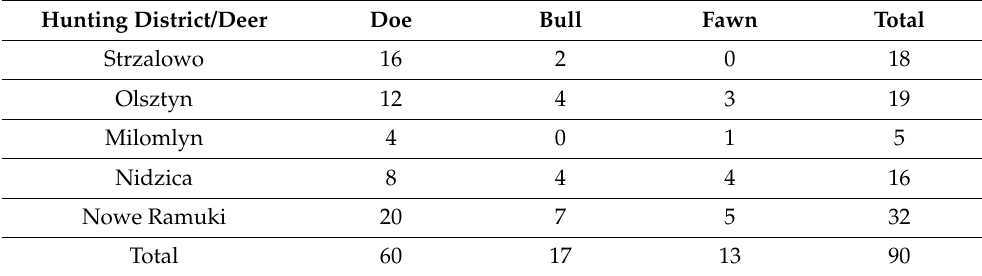
Table 1. Location, status, and number of red deer ( Cervus elaphus) individuals sampled. Hunting District/Deer Doe Bull Fawn Total